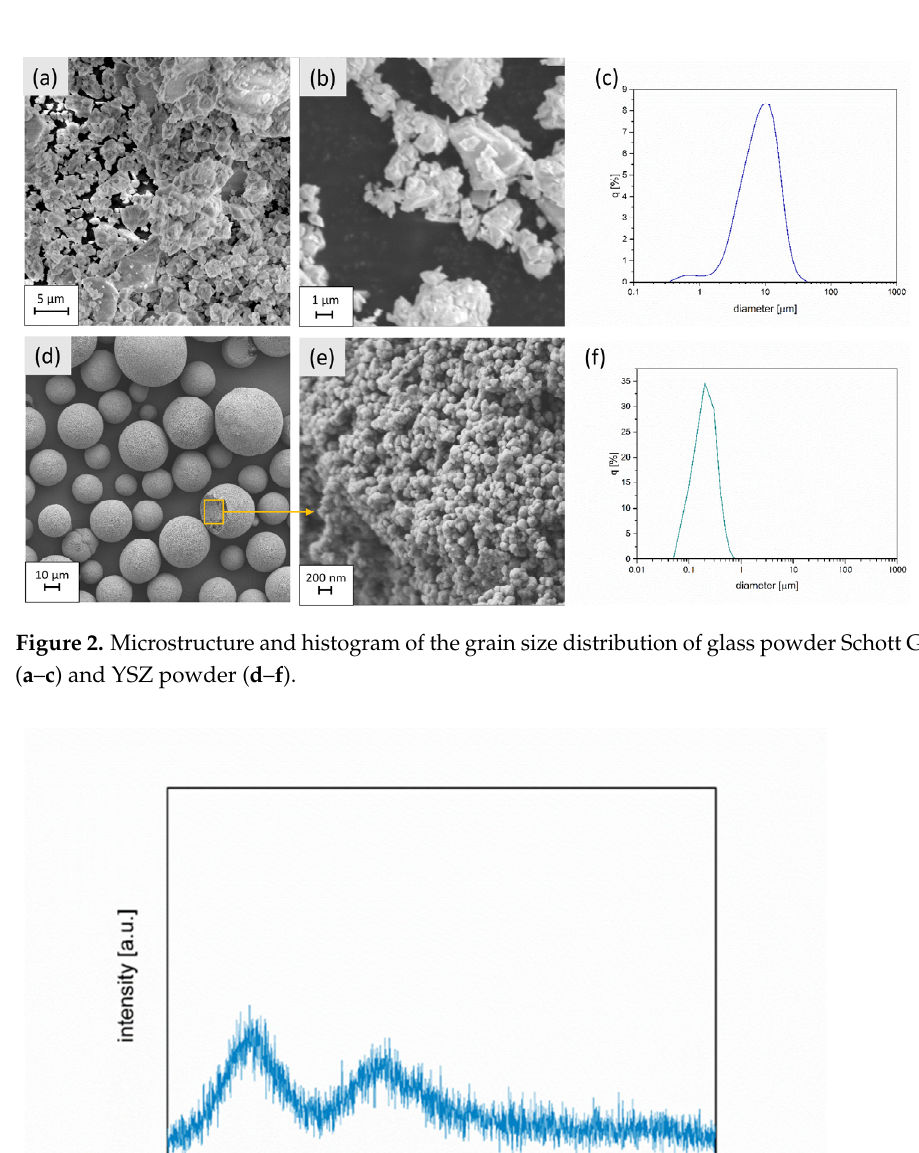
Figure 3. XRD pattern of Schott glass GM31107 powder.